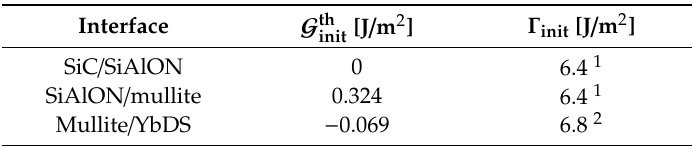
Table 13. Comparison between G th of target interface cracks and fracture toughness for interface crack init initiation ( Γ init ) of corresponding